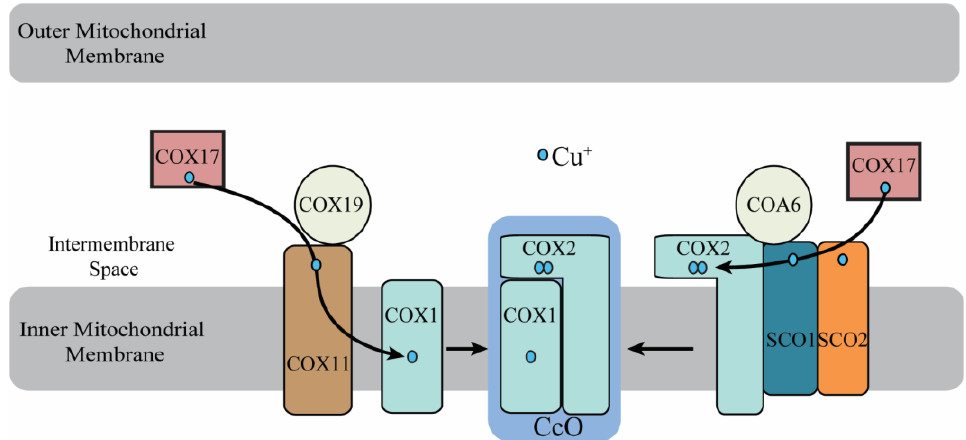
Figure 2. A schematic diagram of the mitochondrial copper delivery pathway to cytochrome c oxi- dase. The copper insertion into CcO is a modular process where COX1 and COX2 metallation occurs separately using a dedicated set of proteins. COX17 is the primary donor of copper to both COX1 and COX2, directly delivering copper to COX11 and SCO proteins. SCO1 is the metallochaperone that inserts copper into COX2, with SCO2 and COA6 facilitating the copper transfer. COX11 is the metallochaperone that inserts copper into the COX1 subunit and requires COX19 for its functional- ity.